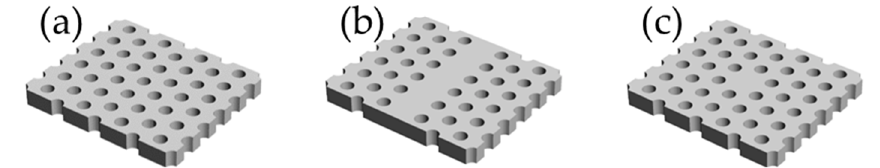
Figure 1. Basic design of photonic crystal (PhC) devices for simulation. ( a ) PhC with an air hole array, ( b ) PhC waveguide, ( c ) PhC resonator.